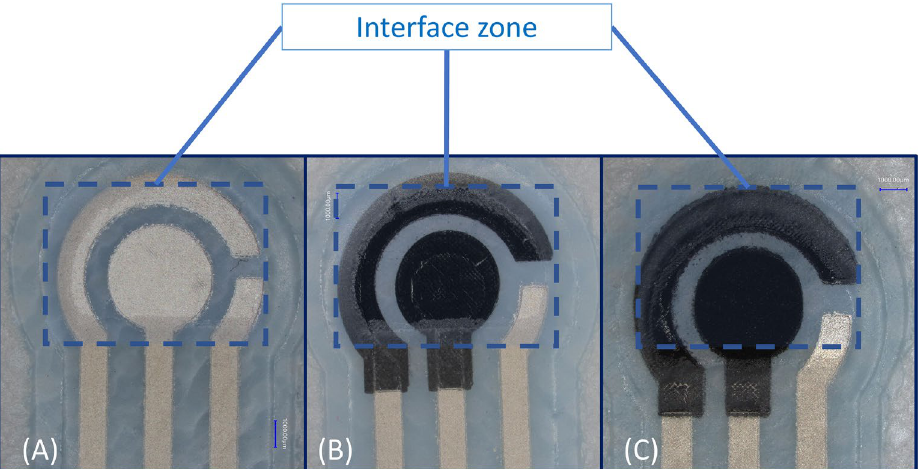
Figure 5. Microscopic images of the three textile SPEs. ( A ) Silver only SPE, ( B ) Carbon and silver SPE and ( C ) Carbon only SPE.